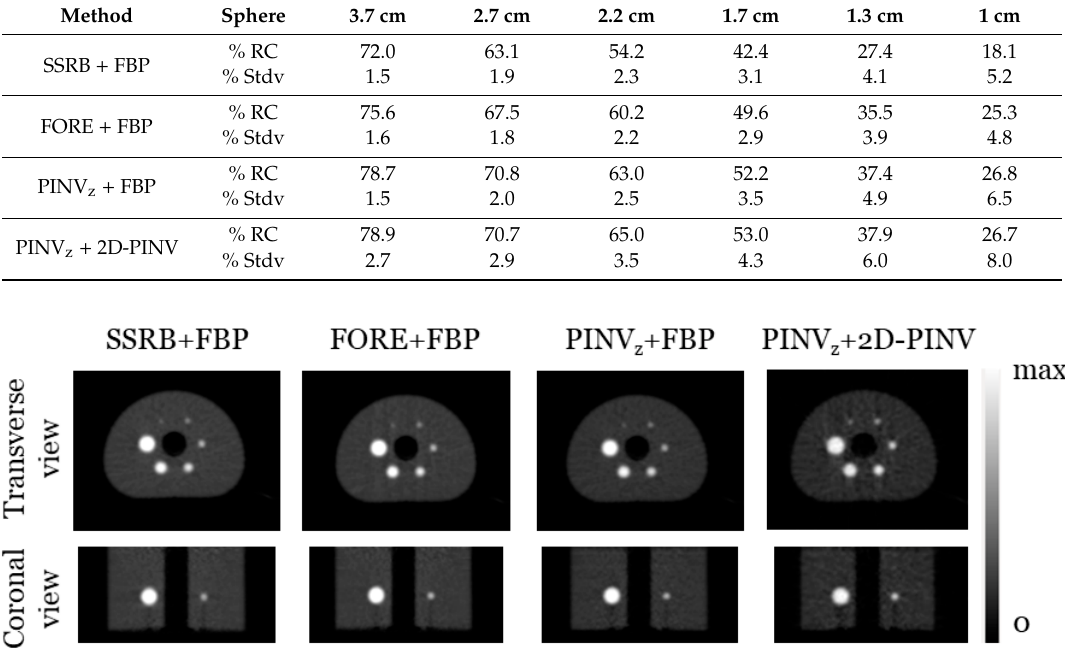
Table 3. Central Processing Unit (CPU) time for the di ff erent rebinning methods using a single core of